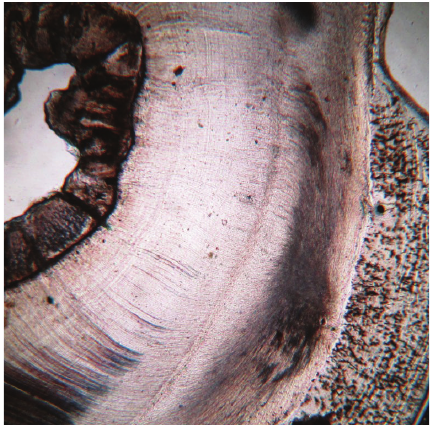
Figure 3: Enamel, dentine and cementum in succession (photomi- crograph, ground section 10x).